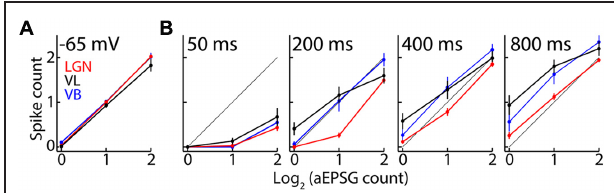
FIGURE 8 | T-type calcium channel activation alters the input-output mode in motor but not visual thalamus. (A) Population spike counts (mean ± SEM) as a function of aEPSG count (log base 2) delivered from − 65 mV for VL (black; n = 19), LGN (red, n = 51), and VB (blue, n = 16). The thin diagonal line (obscured by data) represents the average I–O relation of one spike per two aEPSG observed in vivo in LGN. The amplitude of aEPSG injected from − 65 mV was adjusted in each cell to achieve this relation. (B) As in (A) but for aEPSG delivered from − 80 mV after delays of 50, 200, 400, and 800 ms (left to